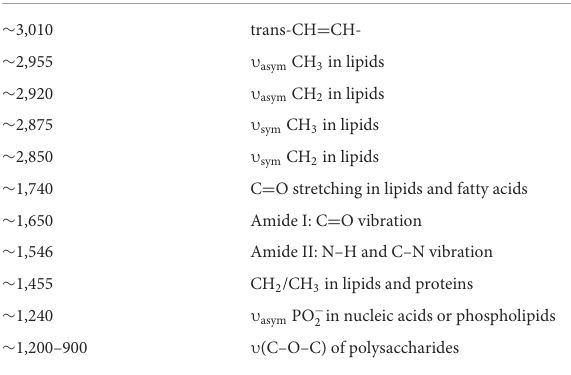
TABLE 2 Assignments of the main absorption bands in the FTIR spectrum of Spirulina .